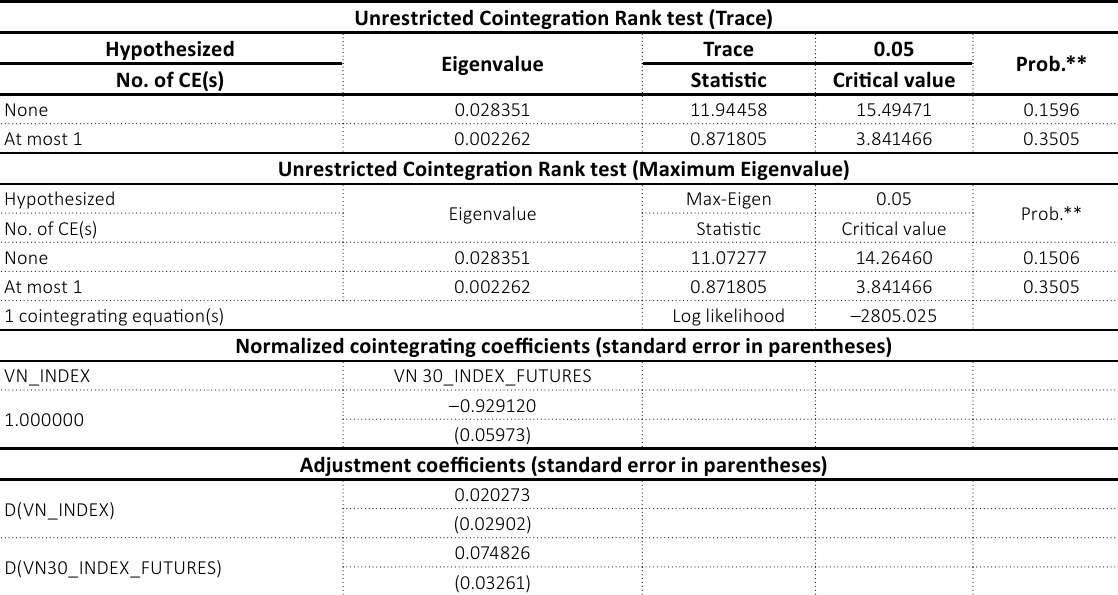
Table 4. Trace and Max-Eigenvalue test for VN 30 Index Futures and VN Index